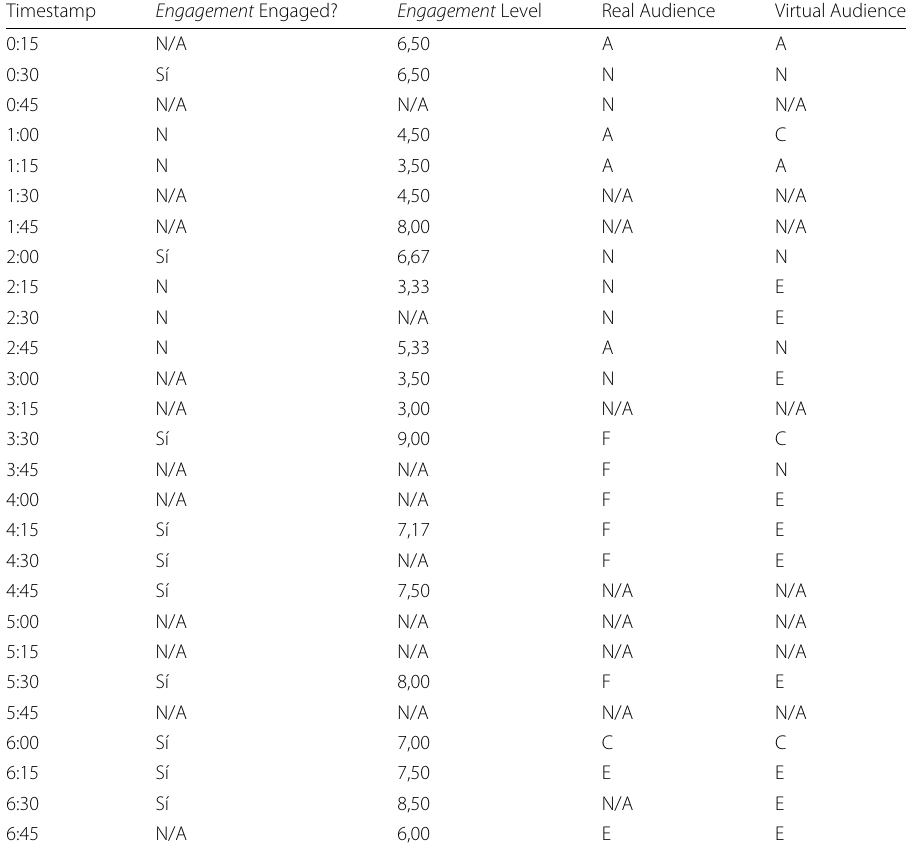
Table 7 Experiment: Results from speech #4 Timestamp Engagement Engaged? Engagement